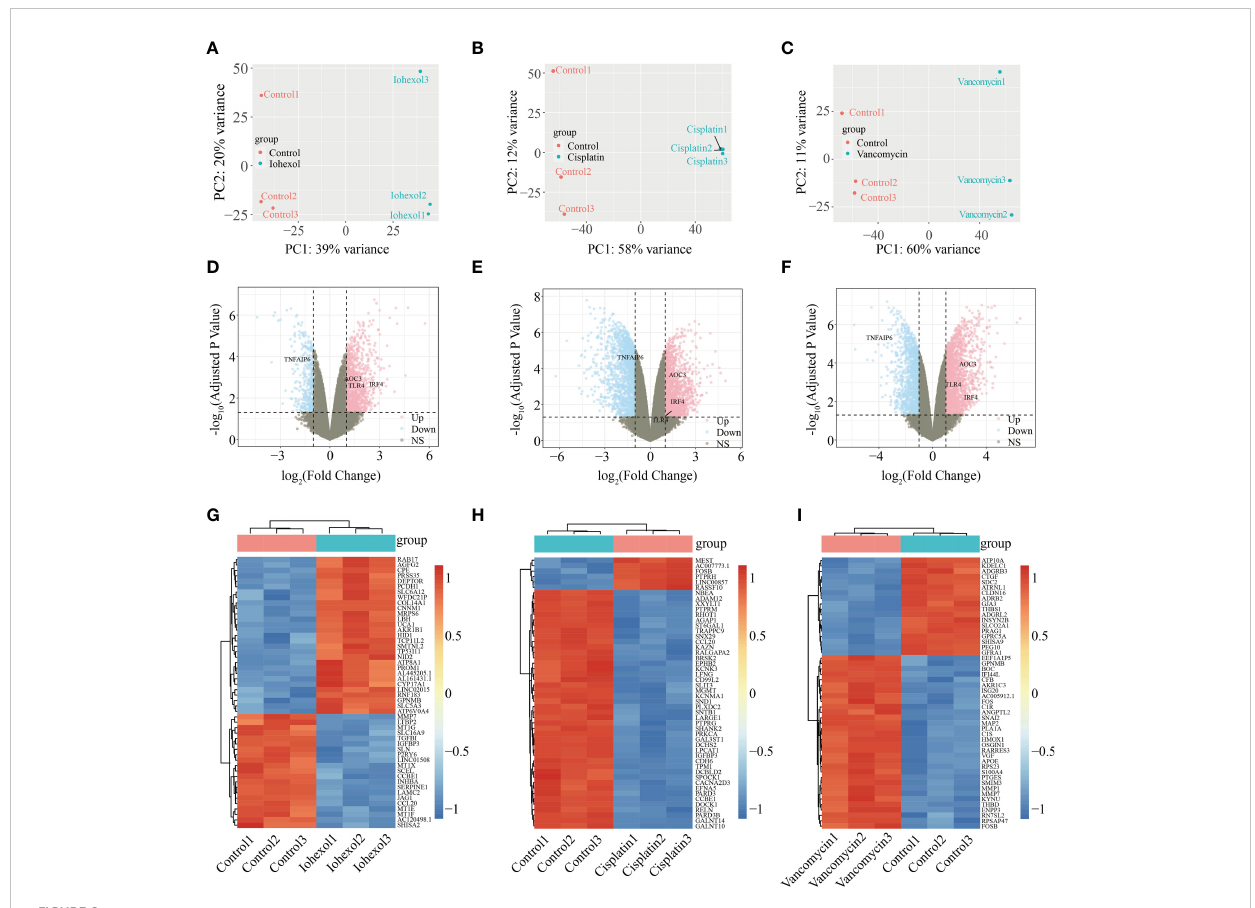
FIGURE 2 Identi fi cation of DEGs from three AKI datasets. (A – C) Differences in principal components between samples treated with iohexol, cisplatin, or vancomycin compared to controls. The control group is represented by red dots, whereas the treatment group is represented by blue dots. (D – F) Volcano plots of DEGs identi fi ed from the three datasets. Pink dots indicates up-regulated DEGs and the blue indicates down-regulated DEGs. (G – I) Heatmap of top 50 DEGs rated by P-Value identi fi ed in three AKI datasets respectively. AKI, acute kidney injury; DEGs, differentially expressed